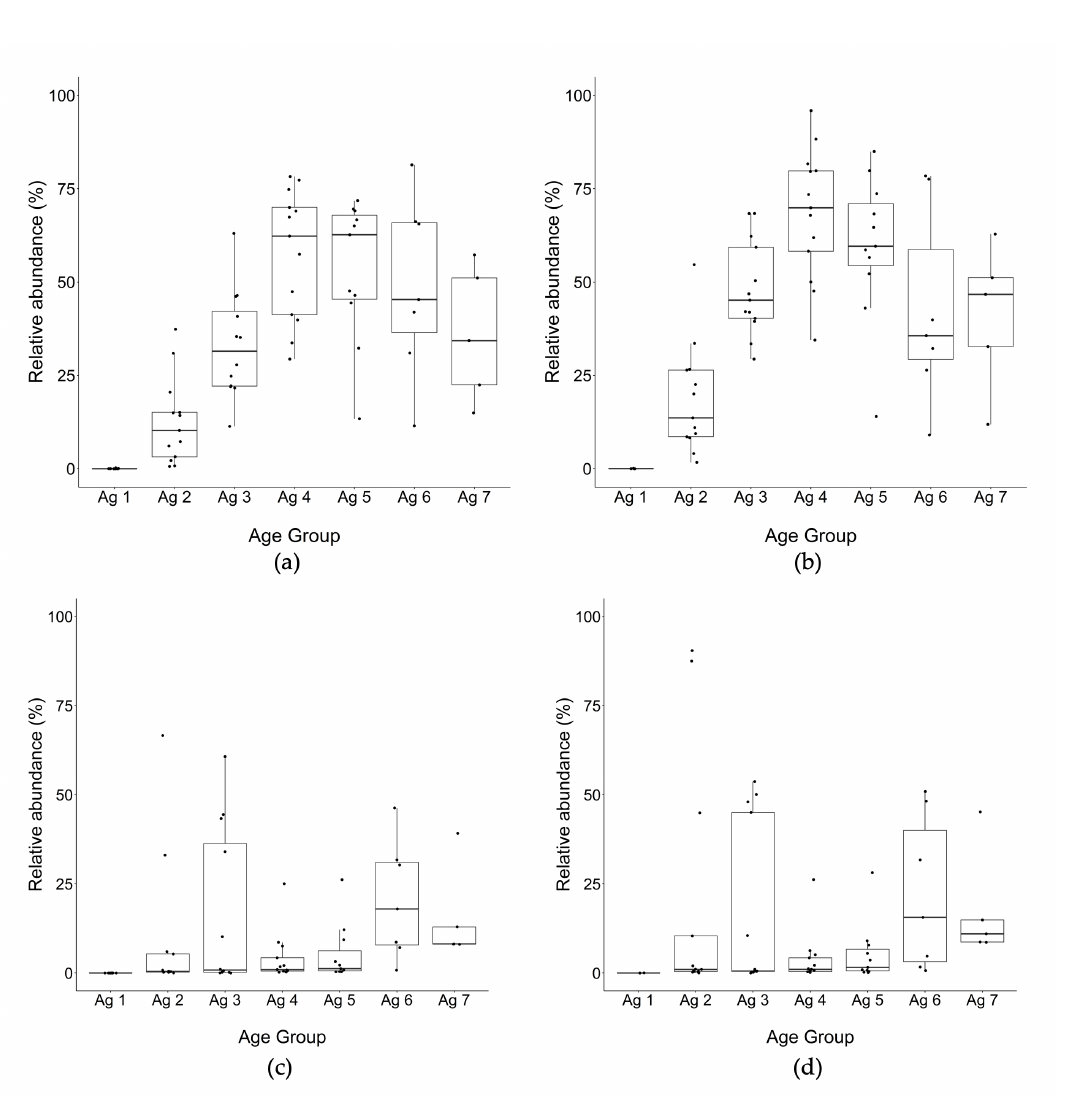
Figure 5. Relative abundance of ( a , b ) Lacticaseibacillus, and ( c , d ) Lactobacillus using OTU classification of 16S rRNA gene amplicon sequences for cheeses from trials 1 to 13 (% of total reads identified to genus level) (left): total DNA, (right): PMA-treated DNA. Ag 1: 0–1 m, Ag 2: 3–6 m, Ag 3: 7–10